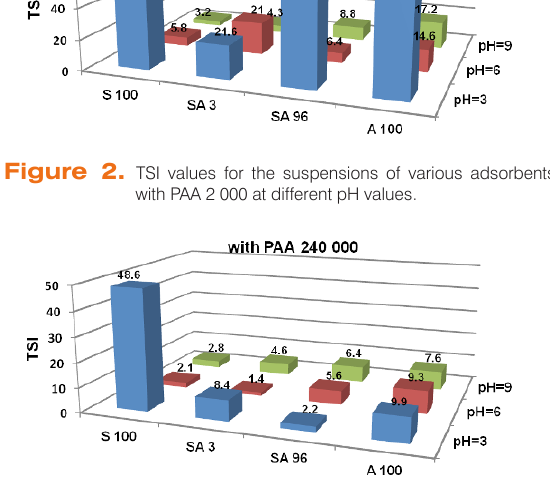
Figure 3. TSI values for the suspensions of various adsorbents with PAA 240 000 at different pH values.